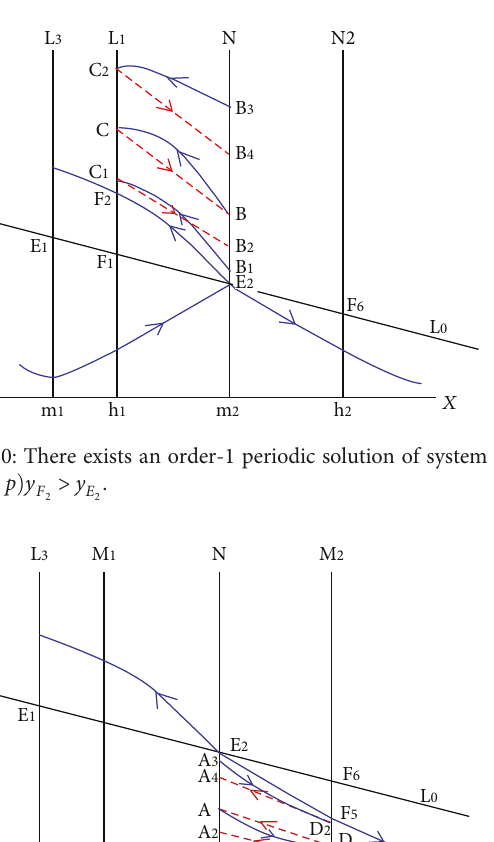
Figure 11: There exists an order-1 periodic solution of system (4) + τ < y with y . F 5 E 2